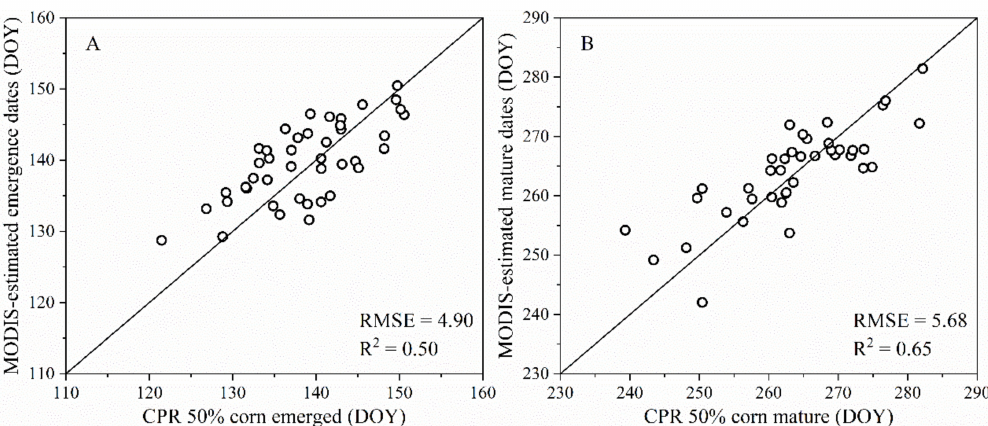
Figure 5. Comparison of the Moderate Resolution Imaging Spectroradiometer (MODIS)-derived emergence date (V1) values, mature date (R6) values, and the United States Department of Agriculture (USDA) Crop Progress Reports (CPR) survey data of 50% corn emerged, mature dates at the state level: ( A ) V1 estimation; ( B ) R6